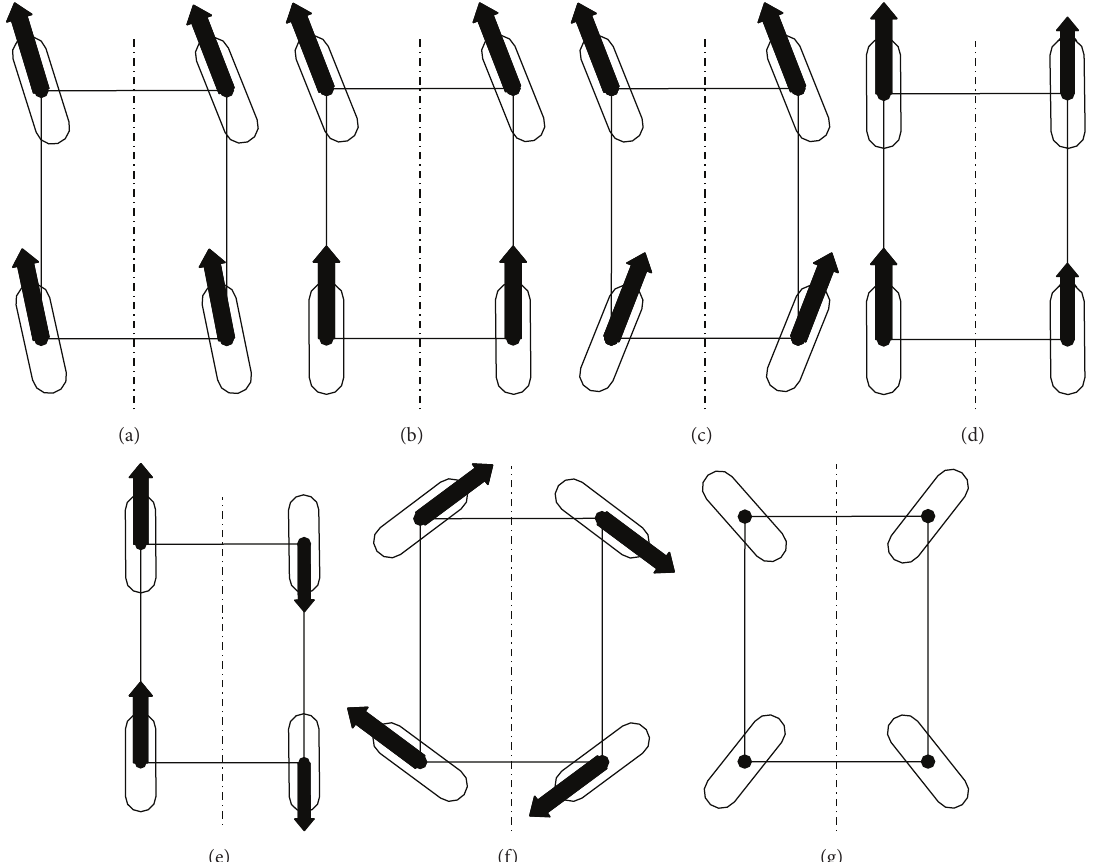
Figure 3: Some basic operation mode. (a) Four-wheel same direction steering, (b) front wheel steering, (c) four-wheel opposite steering, (d) differential speed mode, (e) slide steering mode, (f) zero radius steering mode, and (g) braking mode.